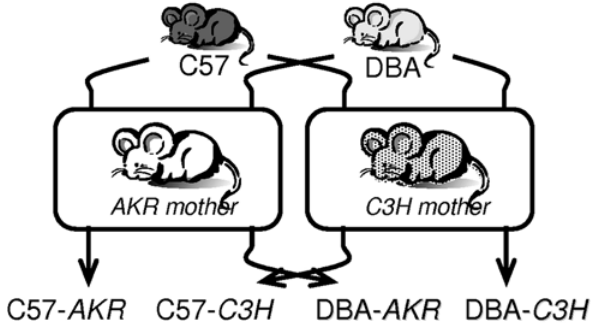
Figure 1. Experimental set-up. Manipulation of the early environ- ment by fostering pups of the C57 and DBA strain with mothers of the AKR or C3H strain.